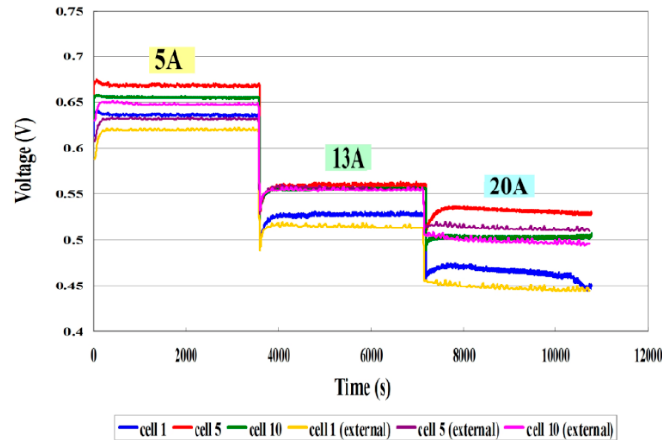
Figure 9. Comparison of internal and external voltages. Figure 10. Comparison of internal and external